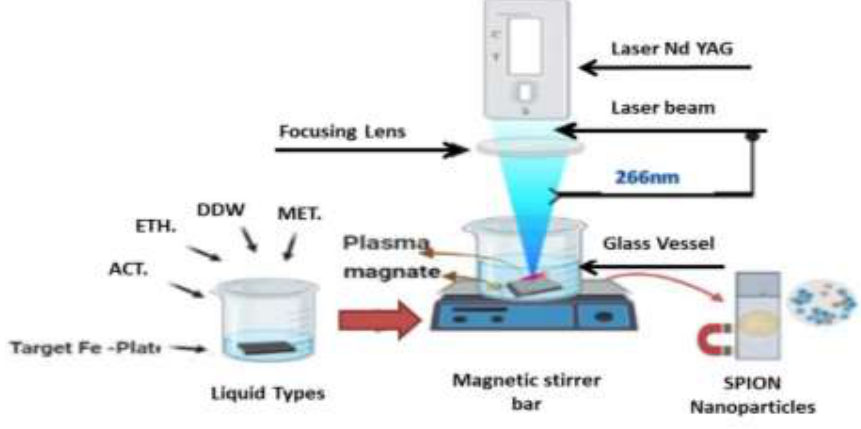
Figure 2: Aschematic presentation of the experimental setup for SPION prepared by PLAIL with different types of liquid.